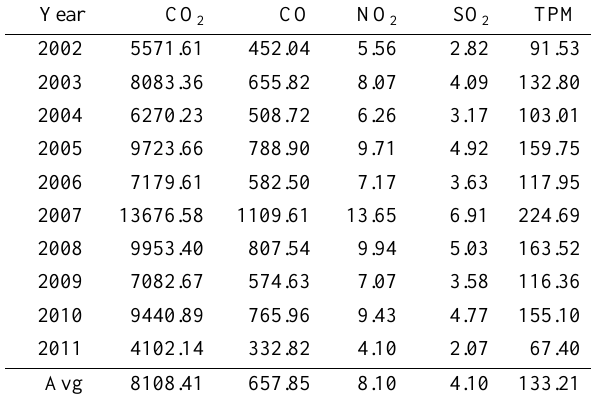
Table 6. Total emissions (Gg) of CO 2 , CO, NO 2 , SO 2 and TPM